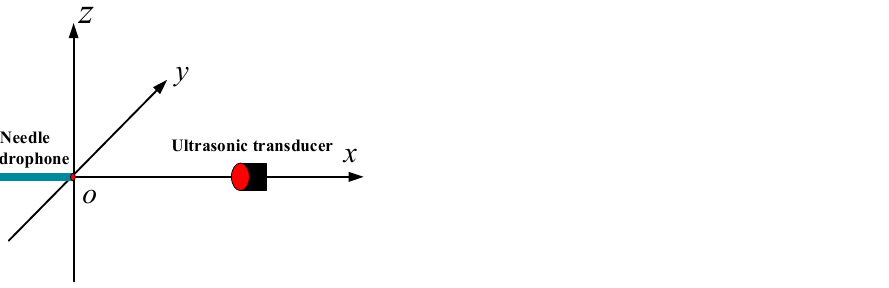
Figure 4. Schematic of the spatial distribution in the radiated acoustic field experiment.